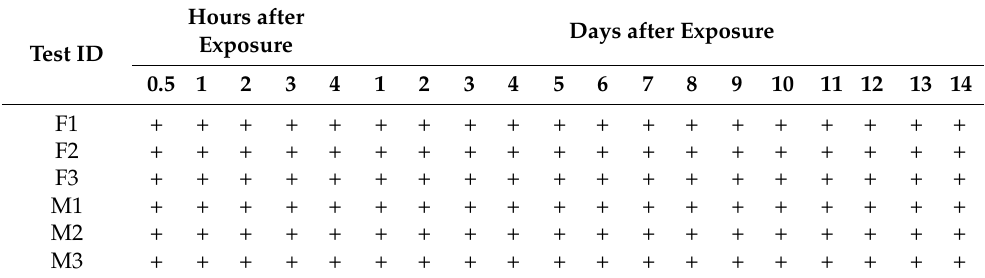
Table 9. Clinical results of test individuals after AgNPs inhalation